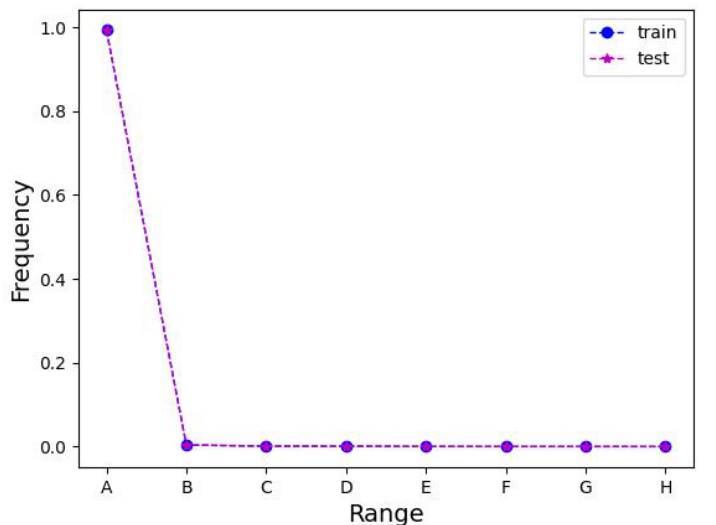
Figure 10. The folding chart of the percentage of different regions in the LEVIR-CD